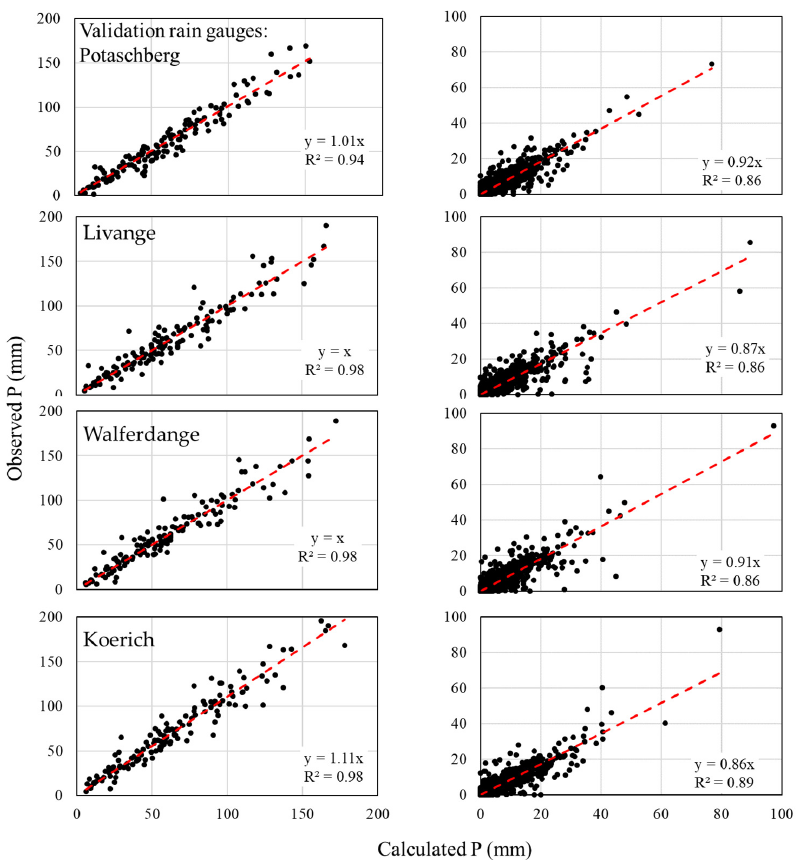
Figure 6. Regression plot of i-FCM model, estimated over observed P(mm); ( Left ) panel: monthly and ( Right ) panel: daily rainfall data.